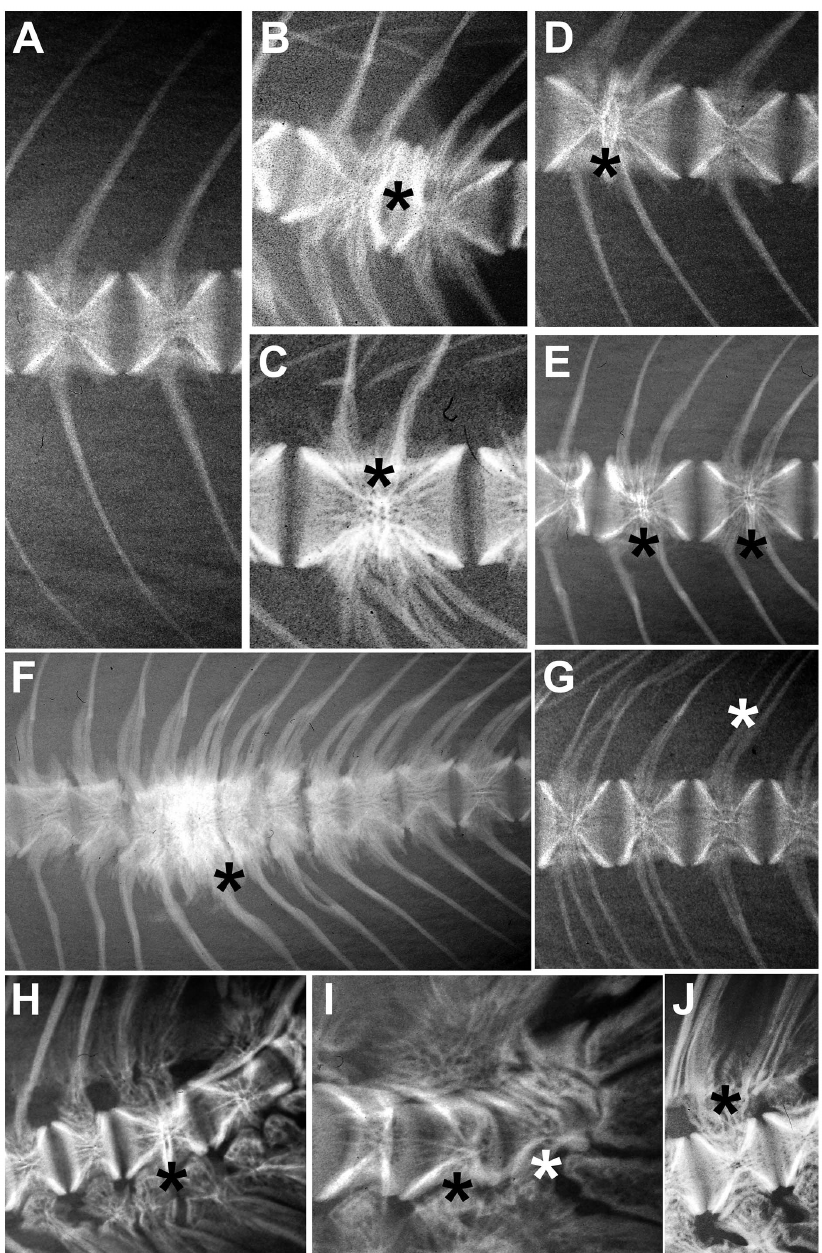
Figure 2. Anomalies observed in rainbow trout specimens. Asterisks indicate the position of the anomalies in the images. A. Normal shaped hemal vertebra; B. one-sided compression of pre-hemal vertebrae (B4), corresponding to type 5 of [58]; C. complete fusion of pre-hemal vertebrae (B3*), corresponding to type 7 of [58]; D. incomplete (C3) fusion of hemal vertebrae; E. complete (C3*) fusion of hemal vertebrae, corresponding to type 7 of [58]; F. compressions and fusions of hemal vertebrae (C3, C3* and C4), corresponding to type 8 of [58]; G. anomalous neural arches (B5); H. incomplete fusion of caudal vertebrae (D3); I. anomalous caudal vertebrae (D4); (J) anomalies of neural spines of caudal vertebrae (D5).